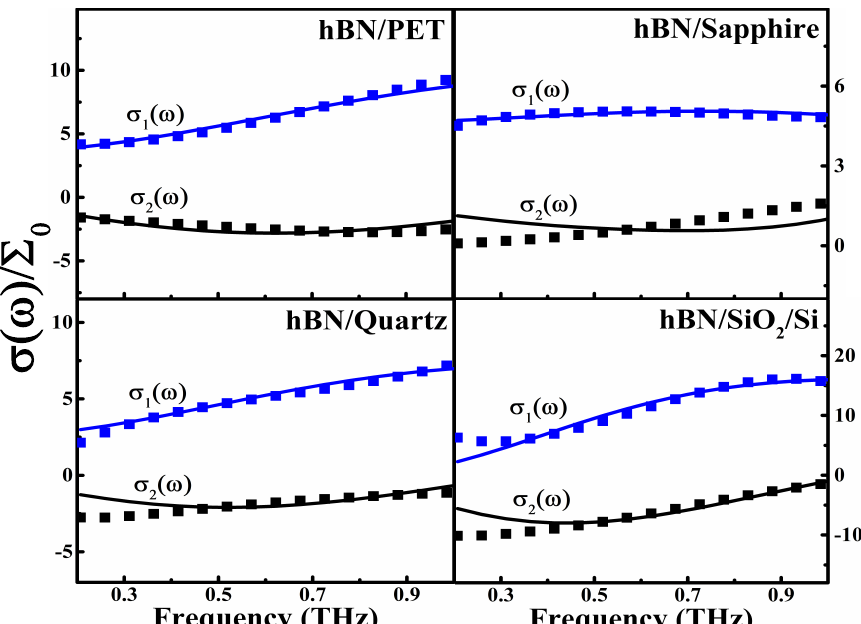
Figure 3. The experimental and fitted (through Drude–Smith formula) real σ 1 ( ω ) and imaginary σ 2 ( ω ) parts of optical conductivity as a function of radiation frequency f = ω /2 π for ML hBN on PET, sapphire, quartz, and SiO 2 /Si substrates at 280 K, respectively. Here, the solid curves are obtained from the Drude–Smith formula, and the dots are experimental data. Σ 0 = e 2 /4¯ h